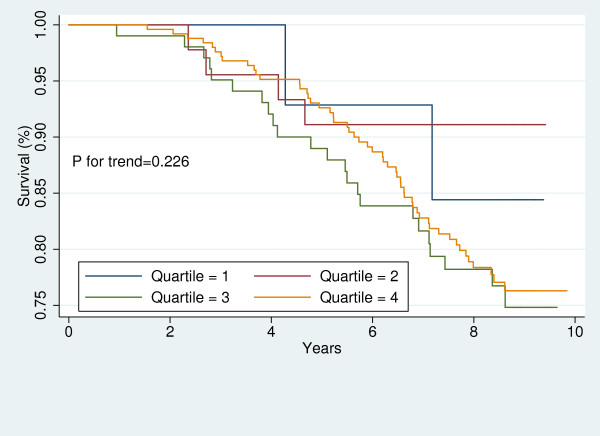
Kaplan-Meier curves for incident CVD across LAP quartiles in women with global CVD risk 20% or more.